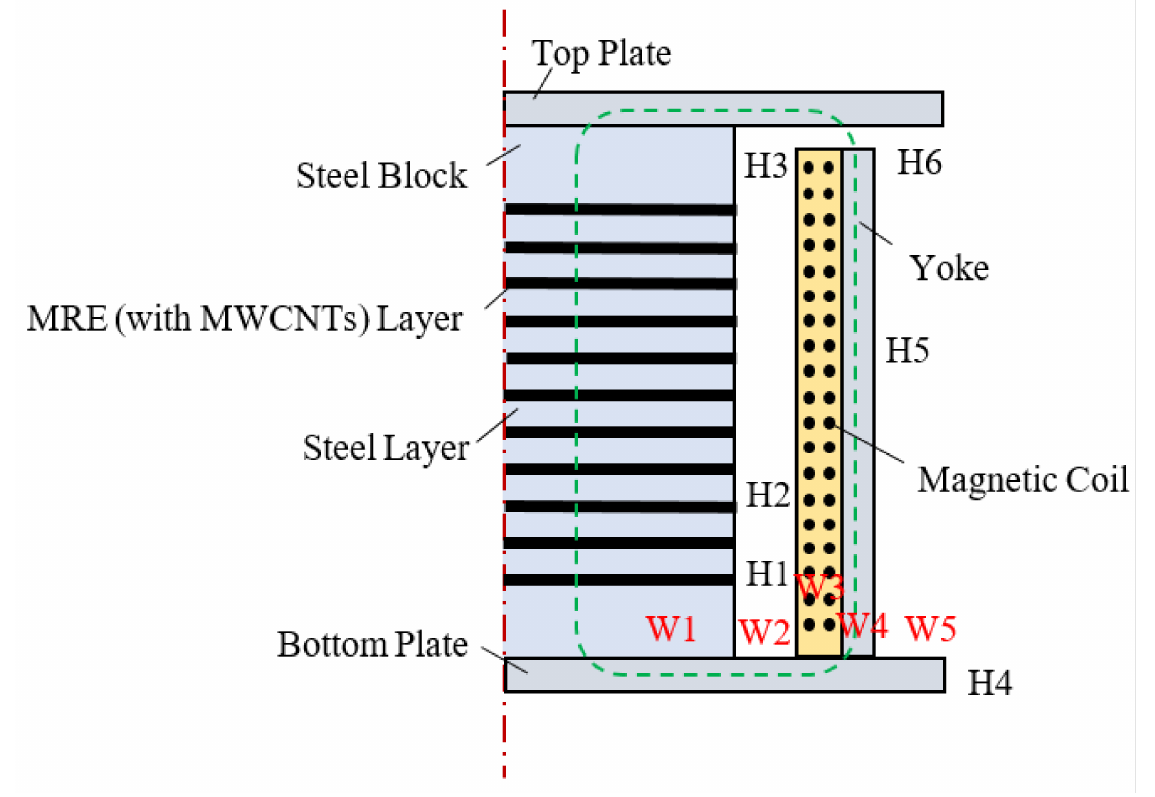
Figure 11. Adaptive Seismic